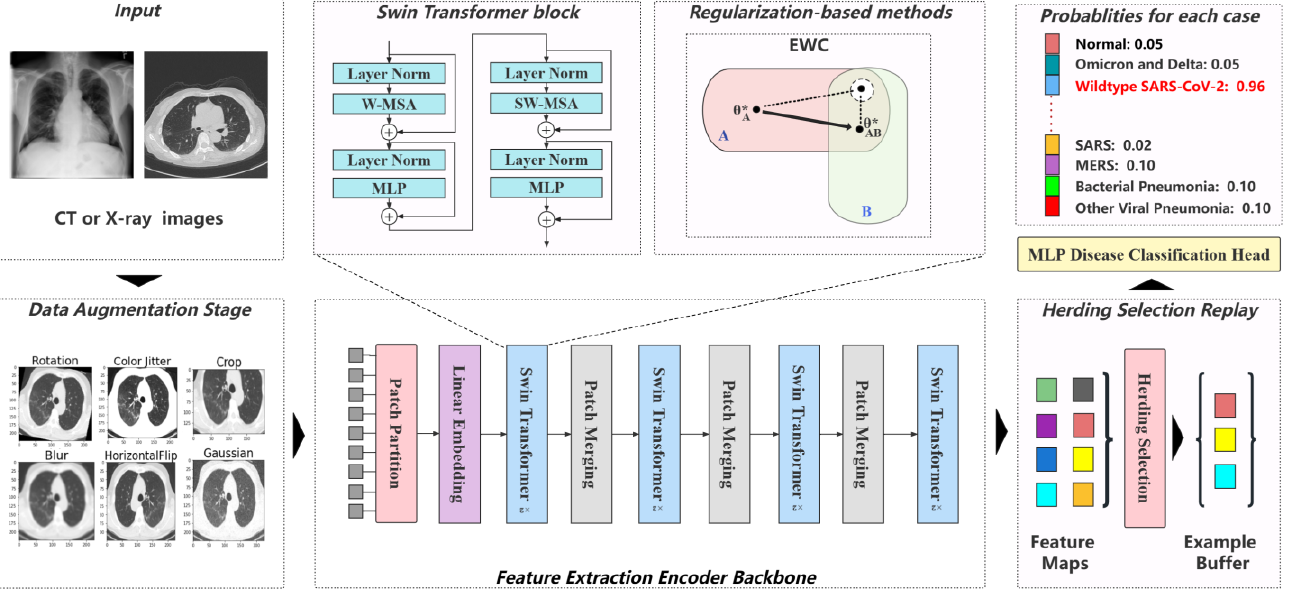
Figure 1. The CoroTrans-CL framework: a Continual Learning approach utilizing a Swin Transformer network for disease detection.